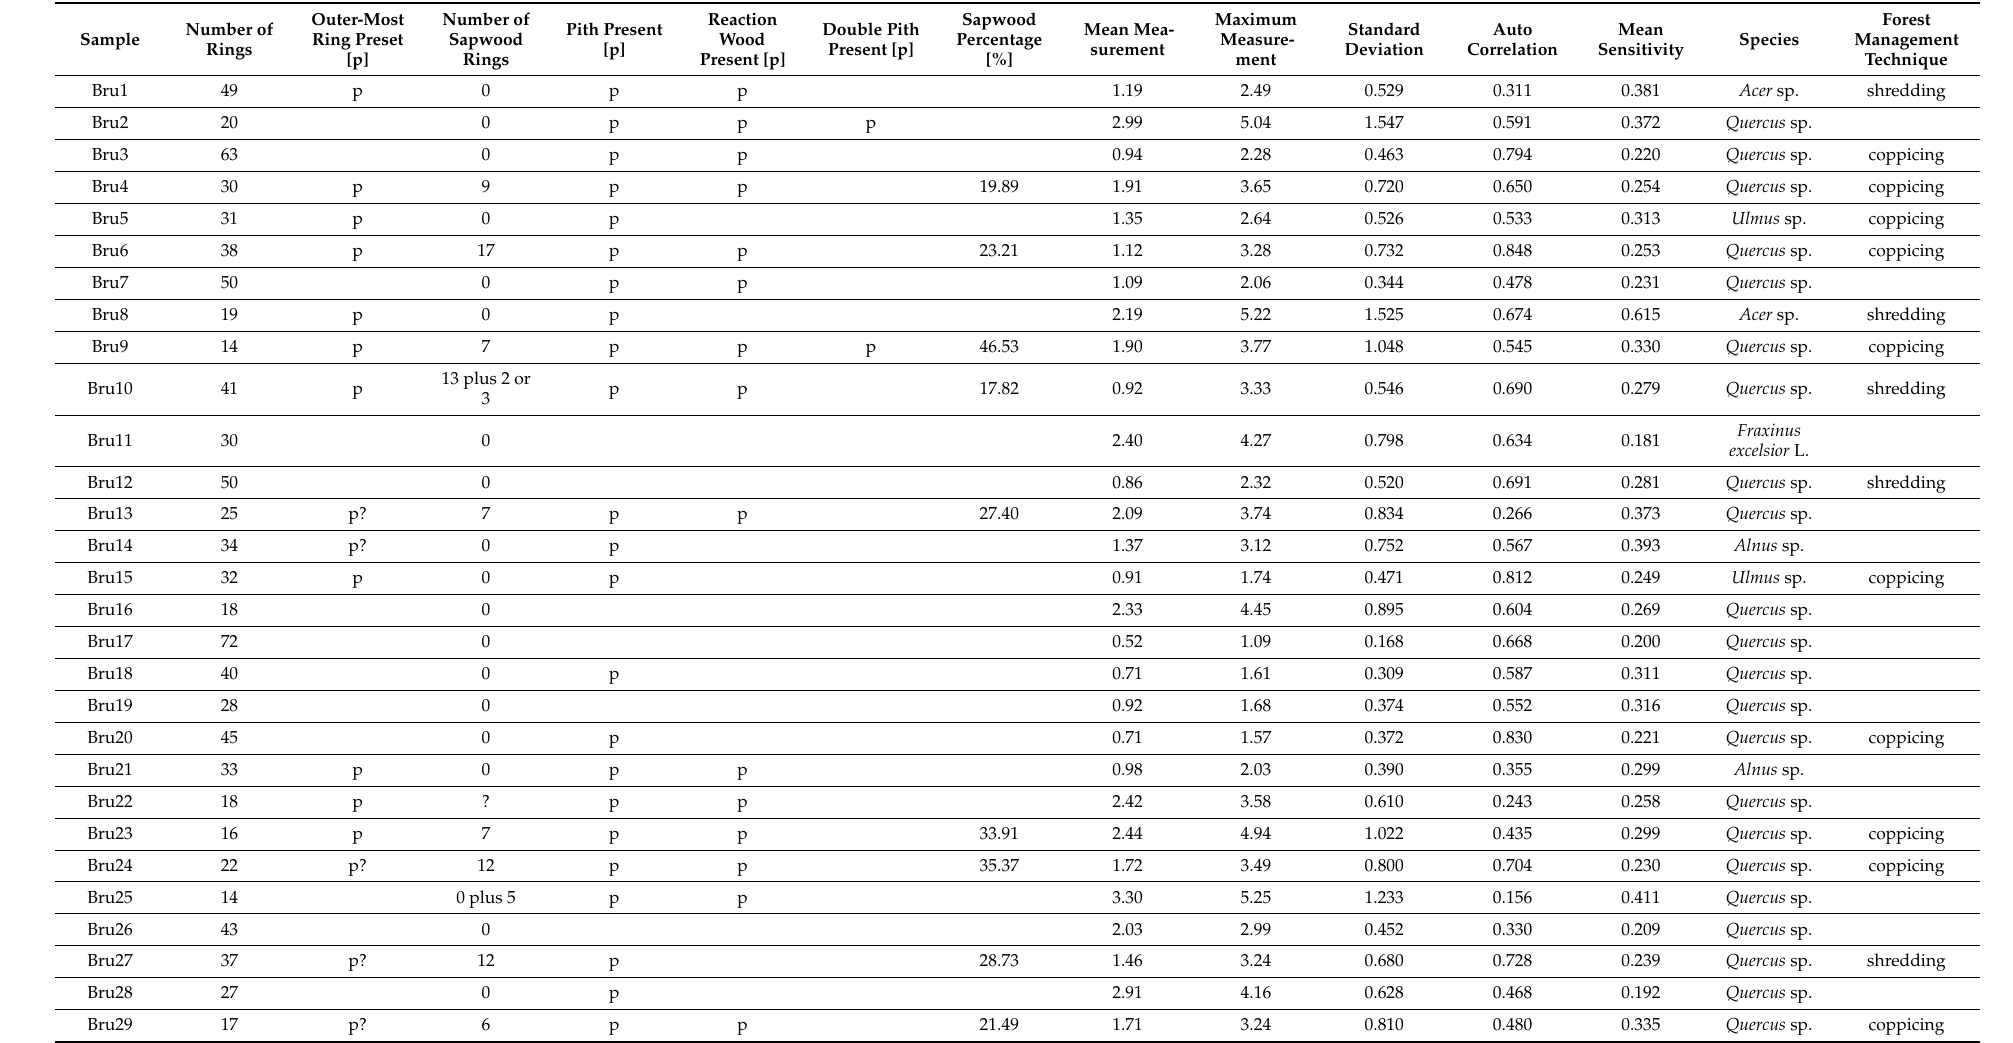
Table 1. Characteristics of the samples from Bruszczewo site used during dendrochronological